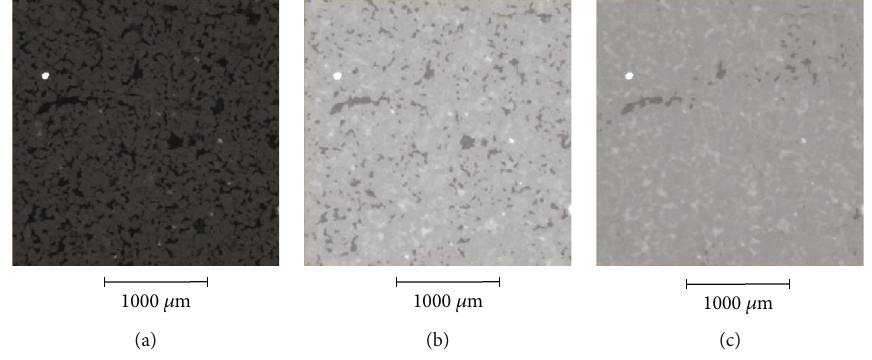
Figure 1: Scanning slices of the core: (a) dry situation, (b) saturated oil situation, and (c) residual oil